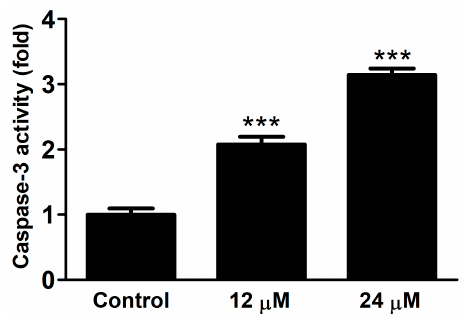
Figure 3. Effect of compound 6 on the caspase-3 activity in HeLa cells as compared to the untreated control. Results are means ± standard error of the mean from 5 replicates. *** indicates p < 0.001, by means of one-way ANOVA followed by Dunnett’s post-hoc test.